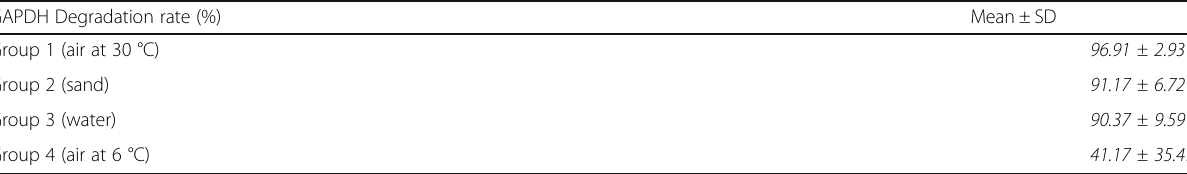
Table 1 Brain GAPDH degradation rates of different groups after 96 h GAPDH Degradation rate (%)